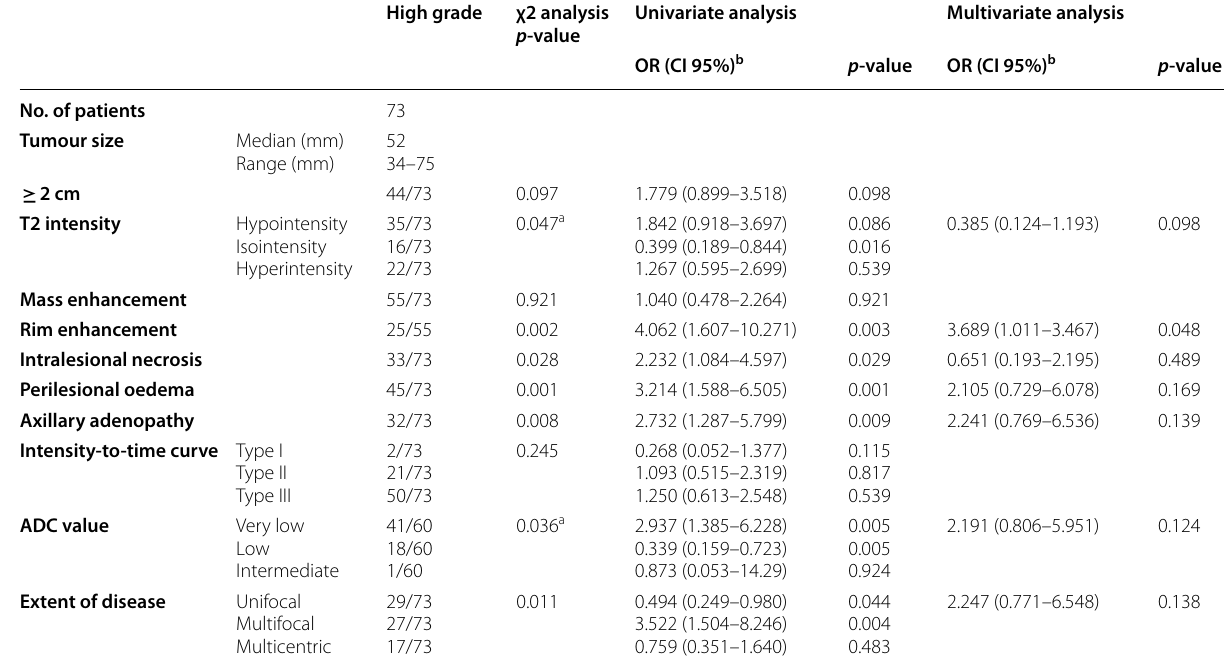
Table 2 Association between breast cancer grading (high grade) and magnetic resonance imaging features